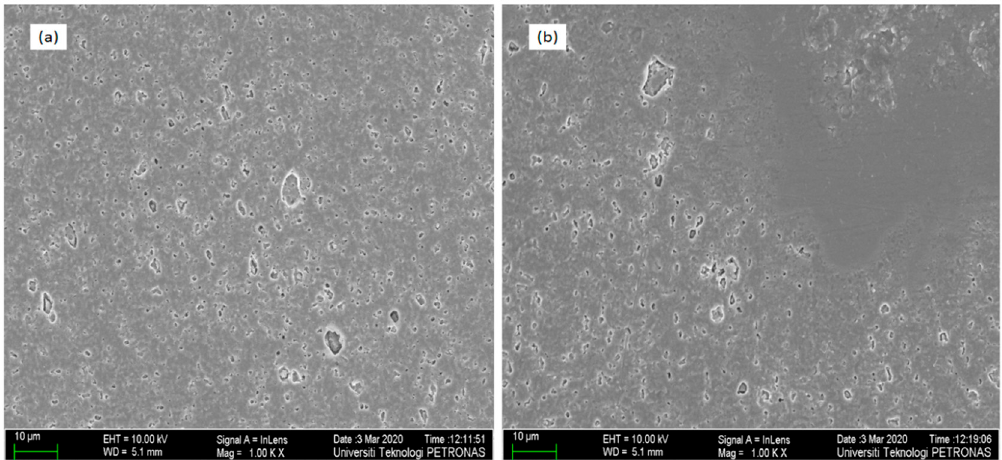
Figure 2. The FESEM micrographs with magnification of 5000× of ( a ) Run 20 and ( b ) Run 9 AA7075-SiC/ fly ash (FA) surface composites.